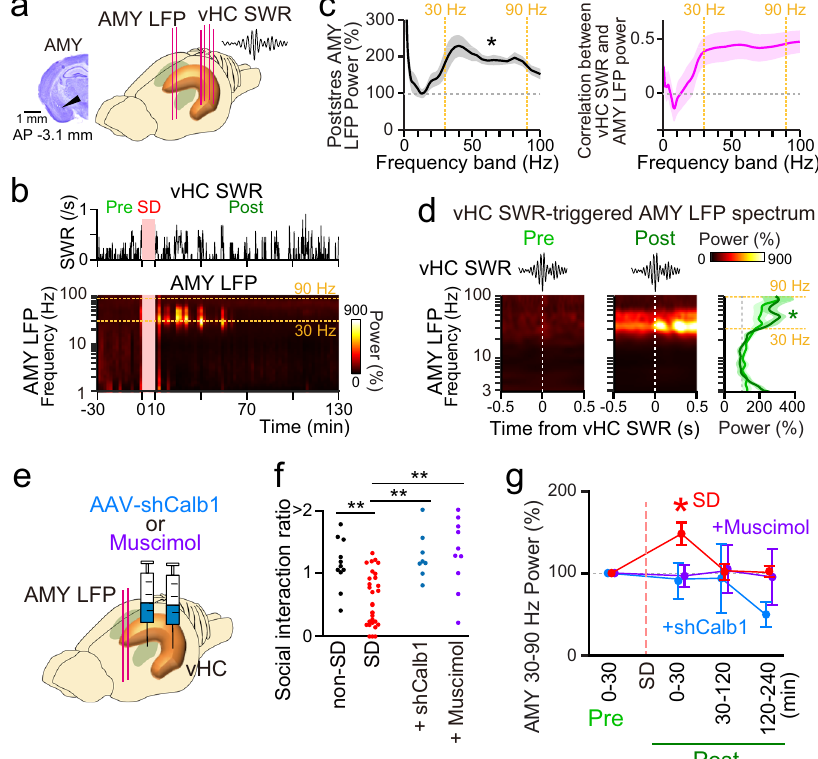
Fig. 4 | Interactions between ventral hippocampal SWRs and amygdalar LFP powerrelatedtoSDstress.a SimultaneousrecordingsofLFPsignalsfromthevHC and the AMY (histological con fi rmation shown in the left panel). The same results were obtained from 5 mice with electrodes implanted in the amygdala. b (Top) ChangesintheventralhippocampalSWRrate(bin=2min)inanSDmouse.TheSD periodwasremovedfromtheanalysis.(Bottom)ThecorrespondingamygdalarLFP power spectrum normalized to the average power during the prestress period in eachfrequencyband. c (Left)AmygdalarLFPpowerinthe30-minpoststressperiod normalized by the 0 – 30-min prestress, plotted against each frequency band ( n =5 mice). The asterisk indicates the 30 – 90Hz band, in which there was a signi fi cant LFPpowerchangebetweenthetwoperiods( t 4 =5.47,* P =0.0055,two-sidedpaired t test ). The data are the mean±SEM. (Right) Correlations between the ventral hippocampal SWR rate changes and amygdalar LFP power changes in the posts- tress period. d (Left) Ventral hippocampal SWR-triggered AMY LFP power spectra in the prestress and poststress periods in an SD mouse. (Right) Average ventral